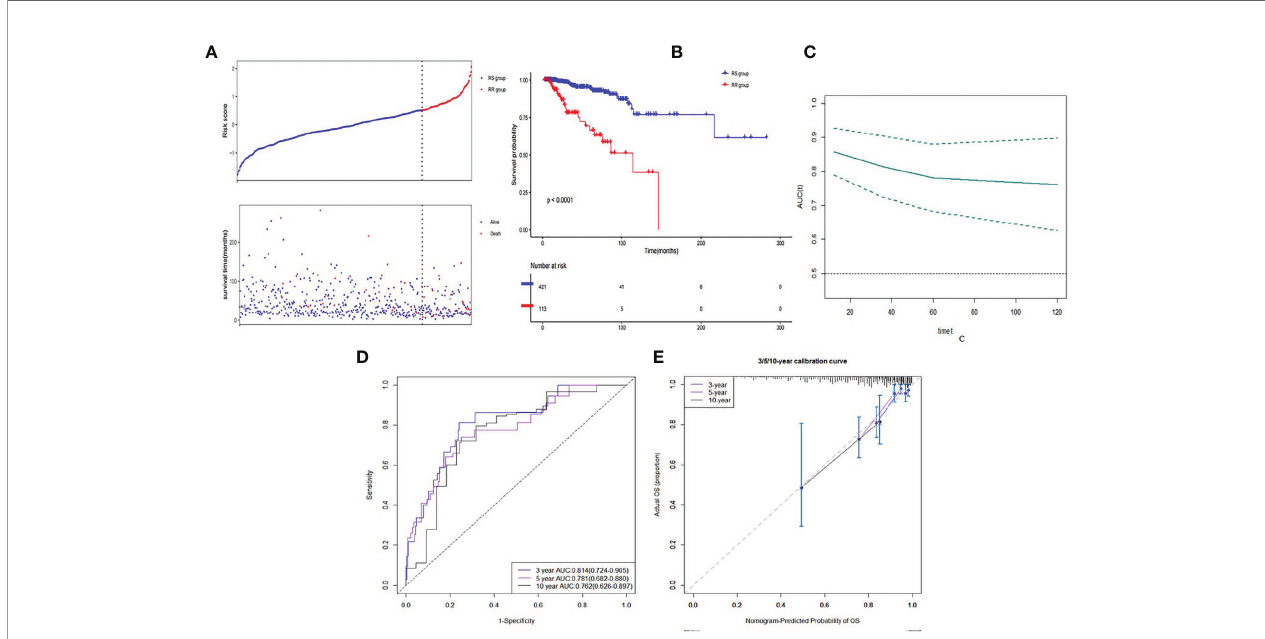
FIGURE 4 | Discrimination ability of gene signature in developed dataset. (A) Low risk score group and high risk score group based on the cutoff value of risk score. (B) K – M curve of comparison for the RS and RR groups. (C) Time-dependent AUC of the risk score. (D) The 3-, 5- and 10-year AUC of the risk score. (E) Calibration plot for 3-, 5- and 10-year AUC of the risk